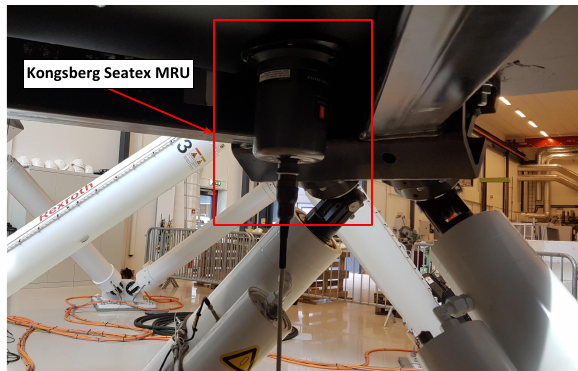
Figure 2: Kongsberg Seatex MRU installed on E-Motion 1500 platform.